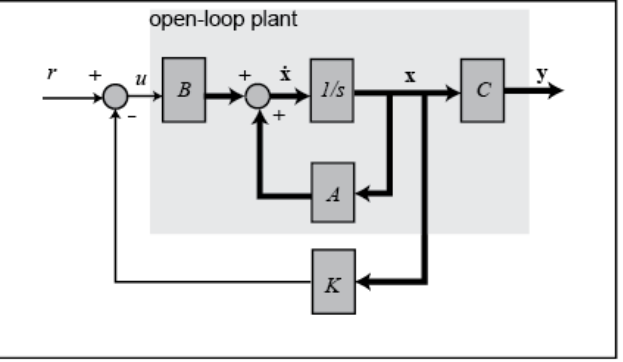
Figure 5. Block representation of the system with K feedback